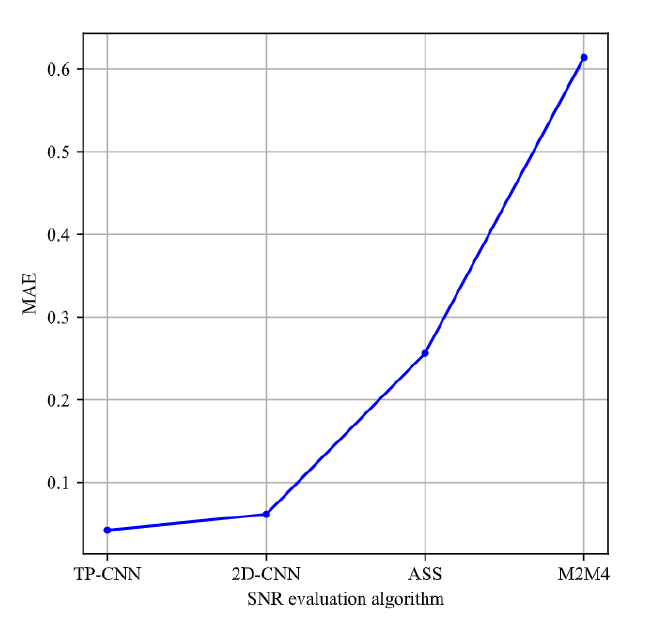
Figure 10. Mean absolute error of the four algorithms for SNR